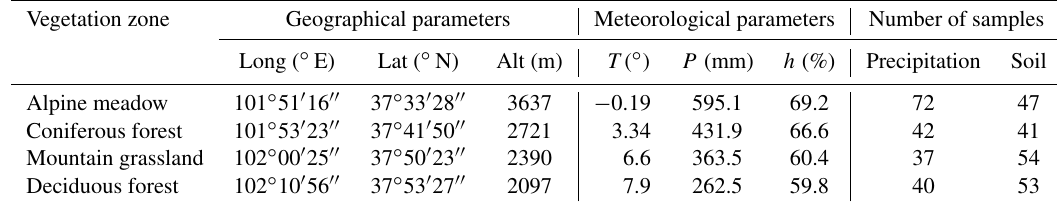
Table 1. Basic data of each vegetation zone from April to October 2017 (Longitude (Long), latitude (Lat), altitude (Alt), air temperature ( T , daily mean temperature), precipitation ( P , total precipitation during the observation period), relative humidity ( h , daily mean relative